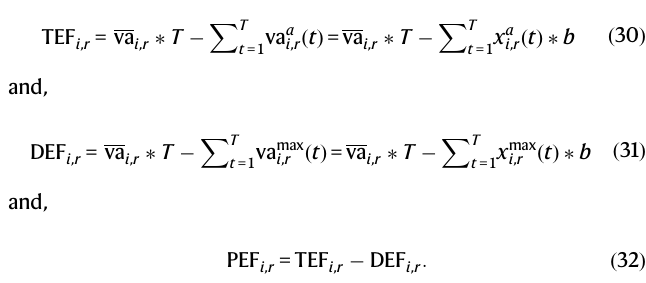
Economicfootprint .Wede fi nethevalue-addeddecreaseofall fi